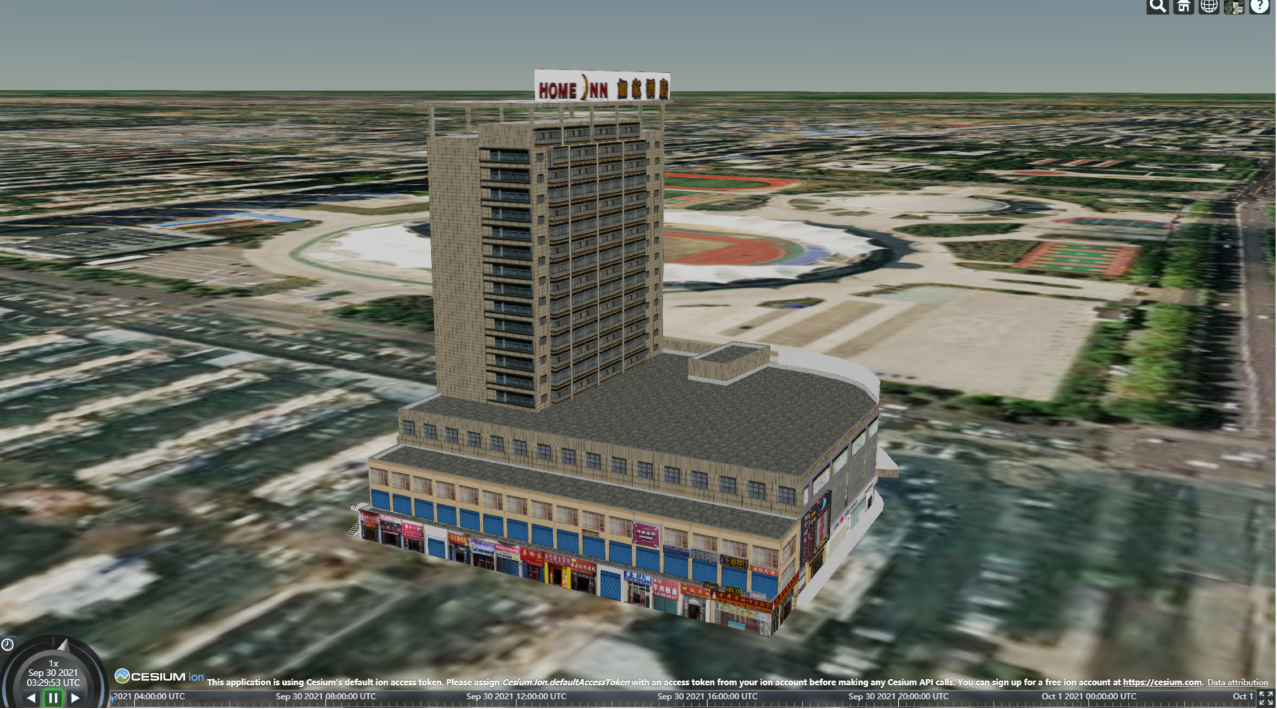
Figure 12. Textured model rendering in